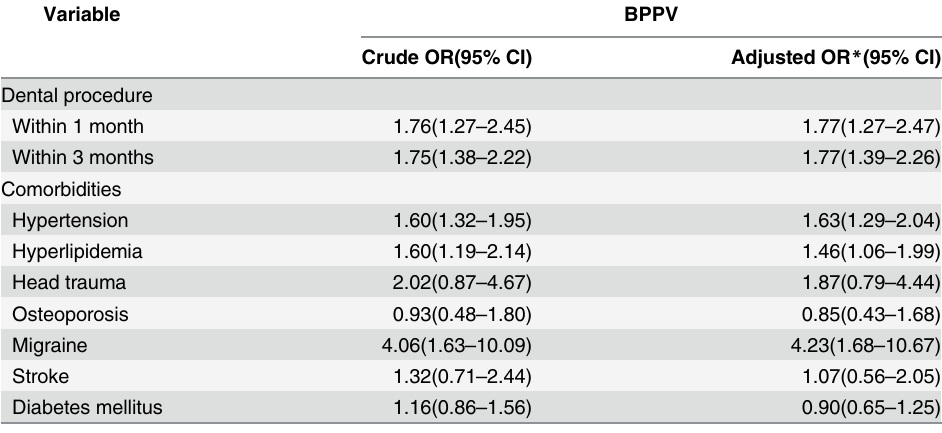
Table 3. Odds ratios for benign paroxysmal positional vertigo with regards to dental procedures and comorbidities.